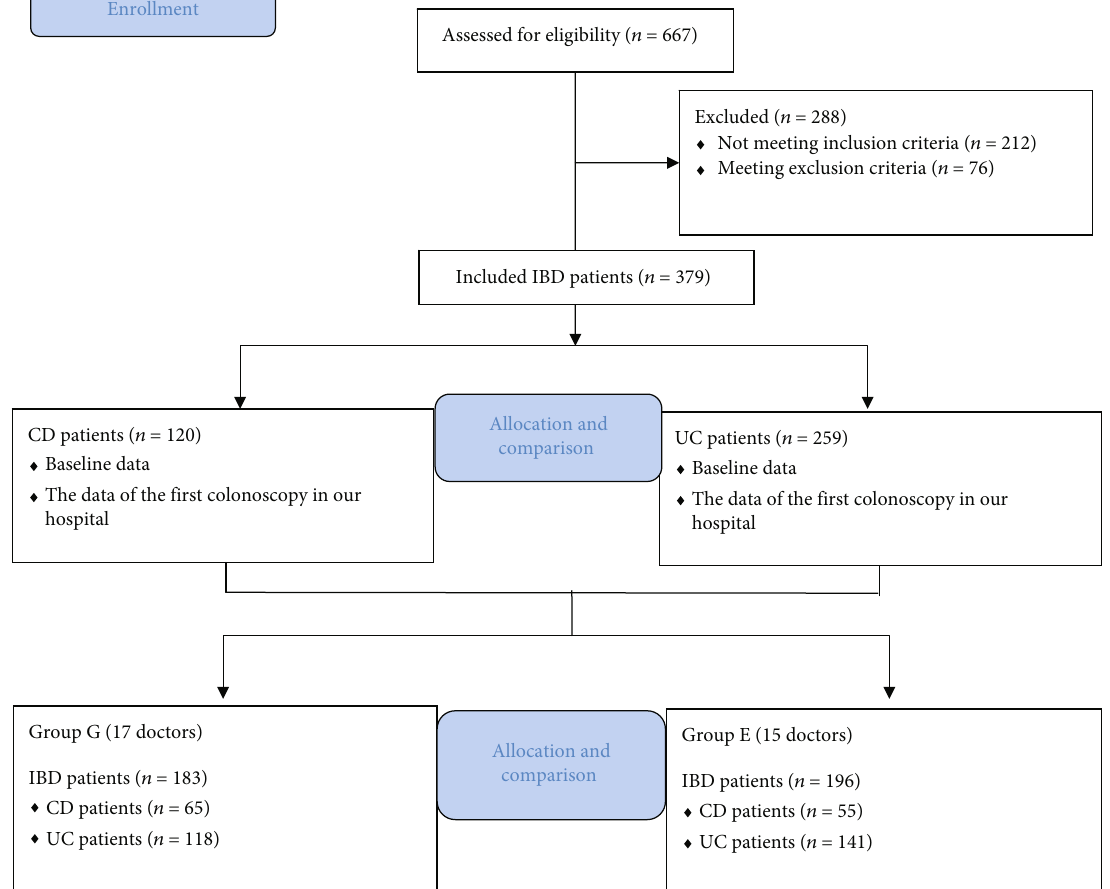
Figure 1: Flow chart detailing the conduct of the